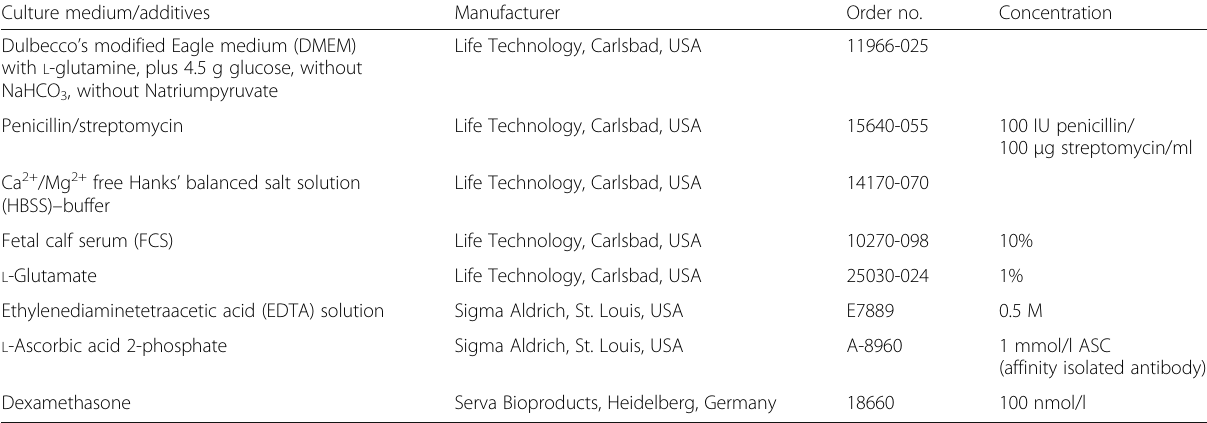
Table 2 Listing of the culture media and additives together with manufacturers ’ data Culture medium/additives Manufacturer Order